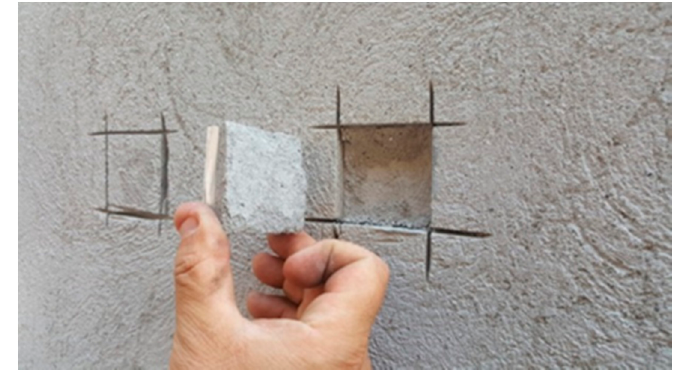
Figure 11. Test area to be patched back.